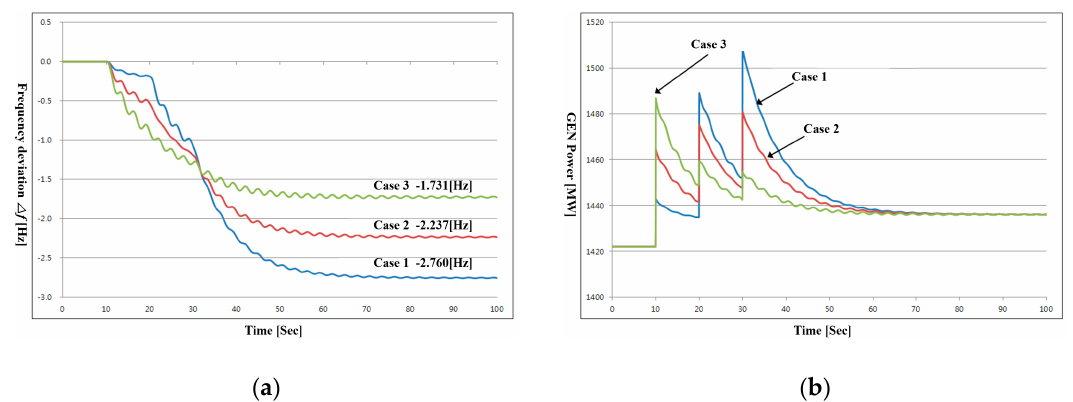
Figure 32. Simulation output for process change: ( a ) Frequency characteristics; ( b ) Load characteristics.